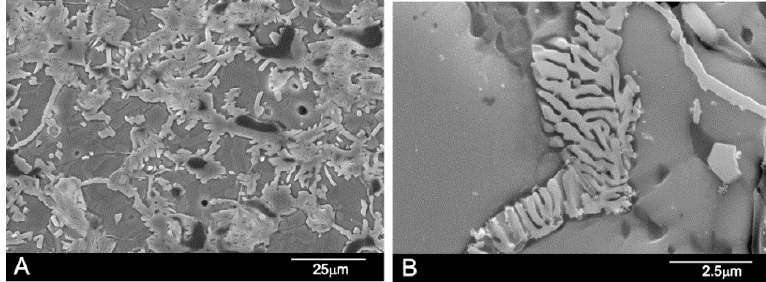
Figure 6. SEM images of sample 55 wt % A/45 wt % S. ( A ) low magnification; ( B ) high magnification. The microstructure corresponding to the composition 28.39 wt % A/71.61 wt % S, is shown in